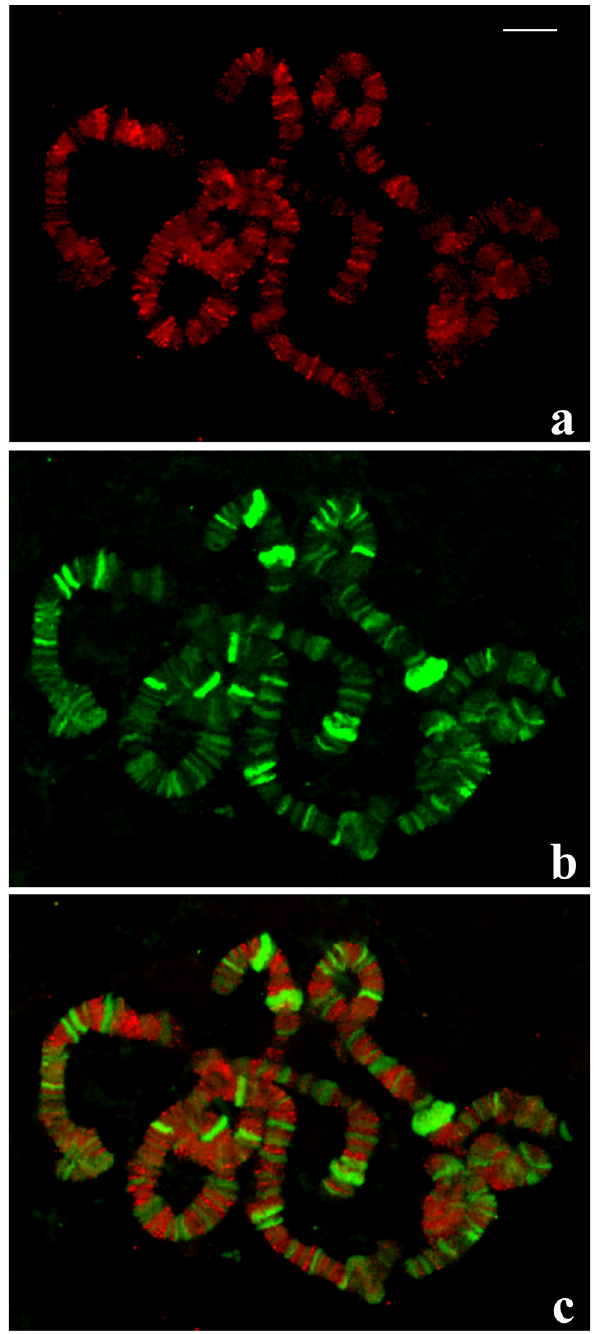
Figure 8. ( a–c ) Distribution of H3K9Me1-3 and RNA polymerase II in Schwenkfeldina sp. polytene chromosomes. Anti-H3K9Me1-3 labelling ( a ), anti-RNA polymerase II labelling ( b ) and the merged signals ( c ). Visualisation of signals from the two markers indicates that both do not usually overlap. Bar = 30